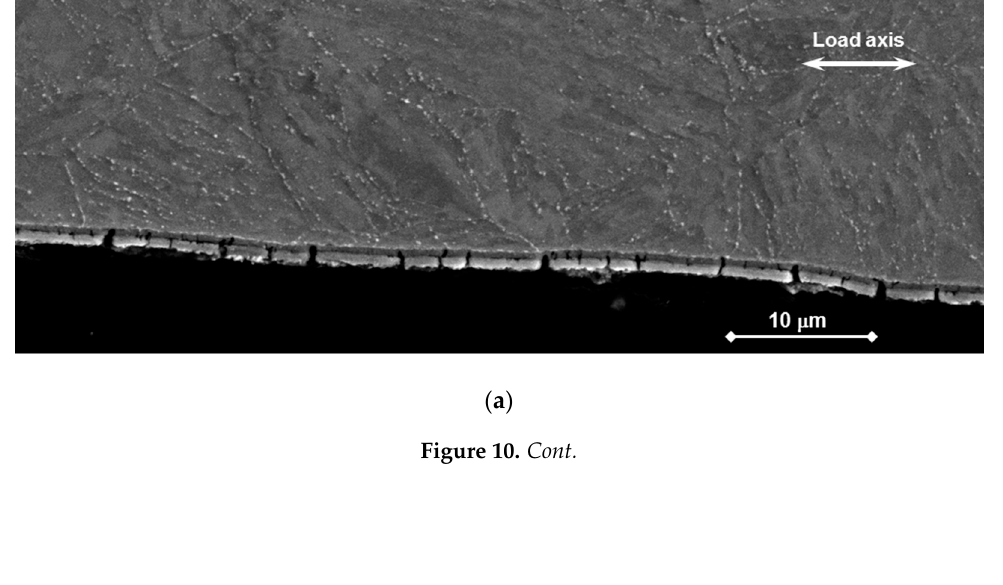
Figure 9. T38 (R2) in Pb, chemical cleaning: ( a ) ground and ( b ) polished surfaces in the minimum cross section.